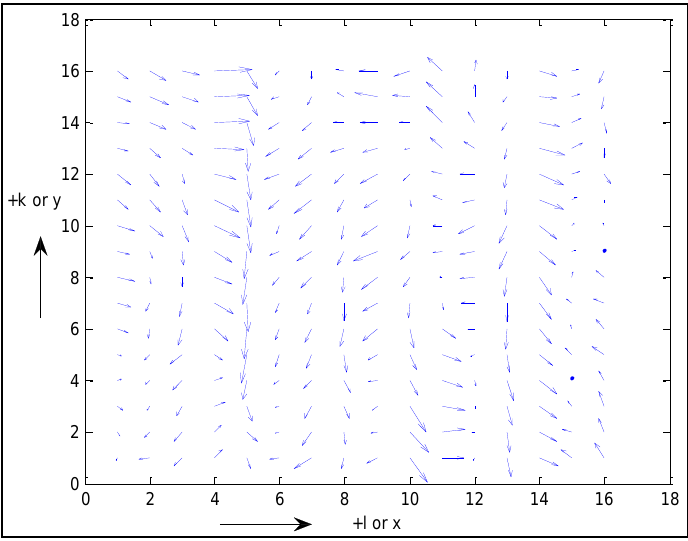
Figure 14. Realization of two-dimensional multivariate errors over a 2D grid: high spatial correlation in the grid’s or y-direction and lower spatial correlation in the grid’s or -direction.